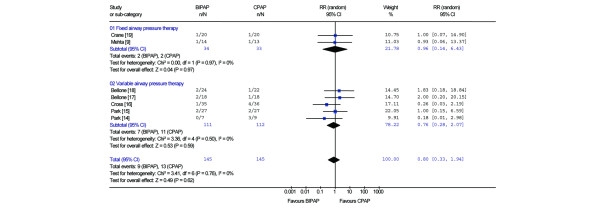
Forest plot: effect of BiPAP and CPAP on risk for requiring invasive ventilation. BiPAP, bi-level positive airway pressure; CI, confidence interval; CPAP, continuous positive airway pressure; RR, relative risk.